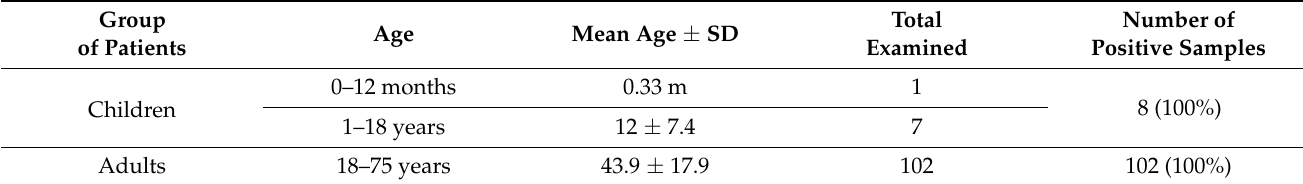
Table 1. Characterization of patients by age in Karaganda, Kazakhstan, 2018–2020. Age